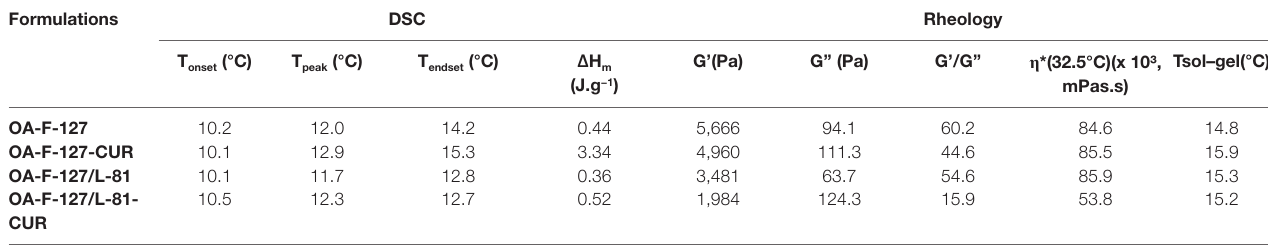
TABLE 2 | Temperatures (T), enthalpy variation (ΔH), and rheological parameters relative to the organogels phase transition before and after curcumin incorporation. Formulations DSC